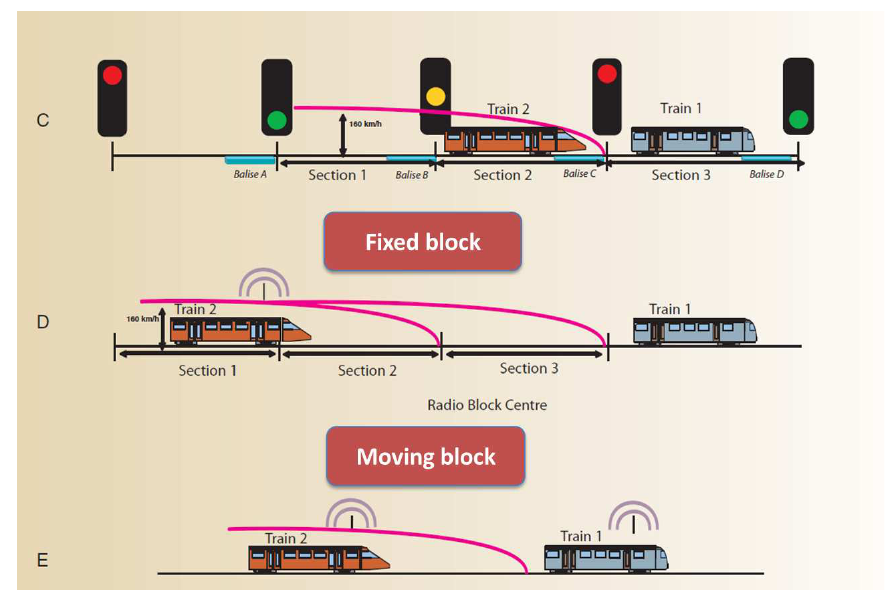
Figure 2. ERTMS standard